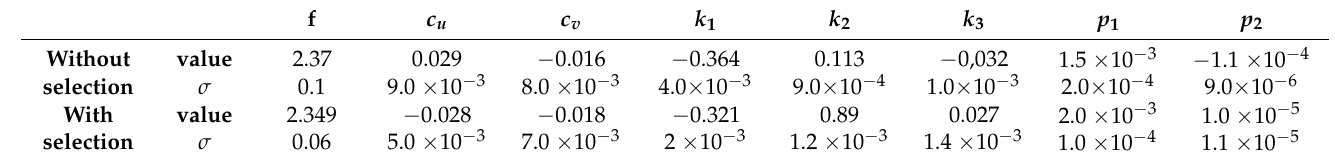
Table 3. Means obtained for each intrinsics coefficient of a Fisheye model and the corresponding standard deviation ( σ ) on calibration sets without and with selection, for a GoPro H3+ camera. f c u c v k